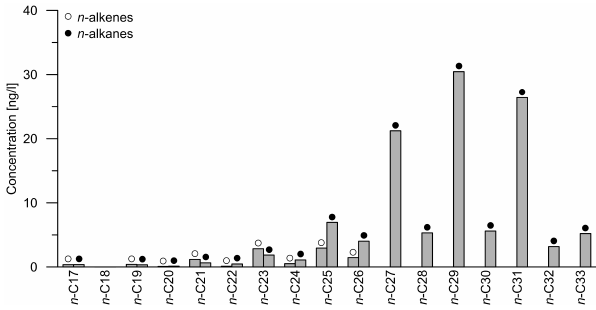
Figure 5. Concentrations of n -alkanes and n -alkenes in the Land- sort Deep surface layer (oxic zone, 10m water